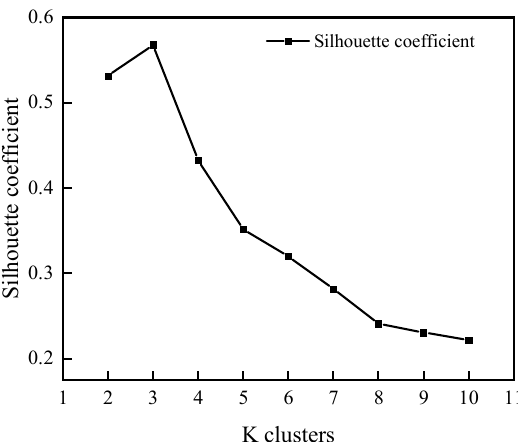
Figure 2. Number of clusters for K-means using the silhouette coefficient.